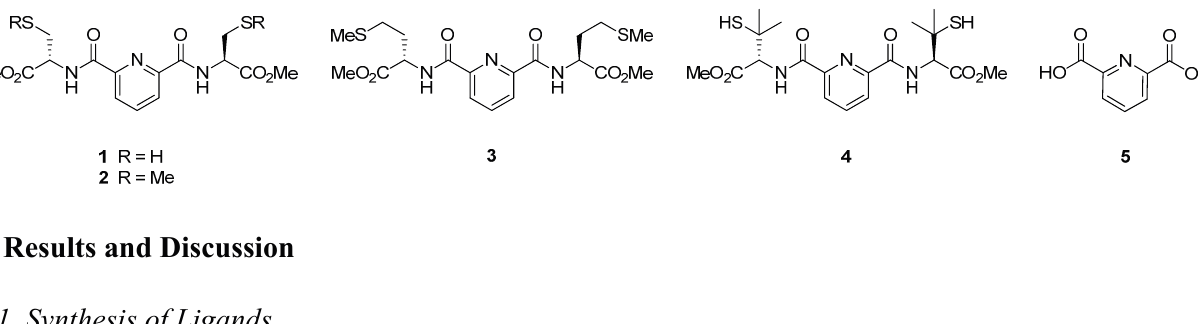
Figure 2. Ligands 1 – 4 prepared and studied in the current investigation are based on pyridine-2,6-dicarboxylic acid 5 and sulfur-containing amino